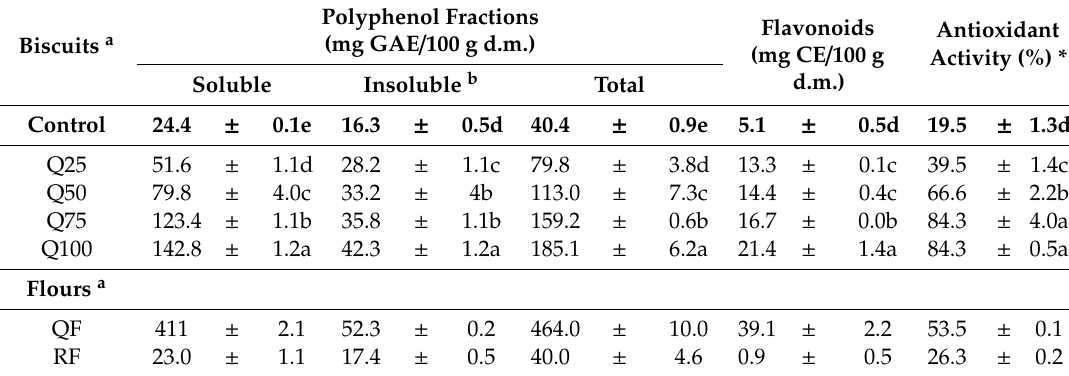
Table 2. Polyphenol fractions, total flavonoids, and antioxidant activity of quinoa flour, rice flour, gluten-free control, and fortified ladyfinger biscuits. Polyphenol Fractions (mg GAE / 100 g d.m.) Biscuits a